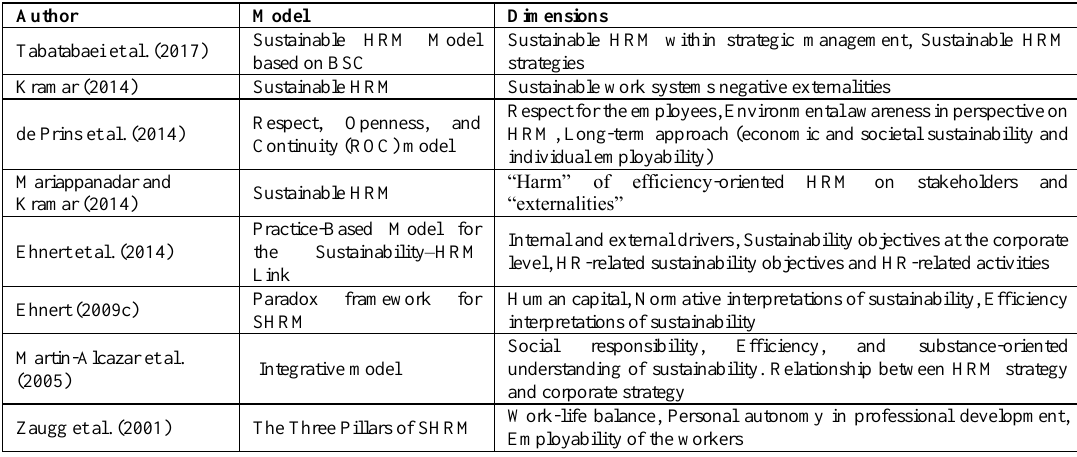
Table 2. Models of sustainable